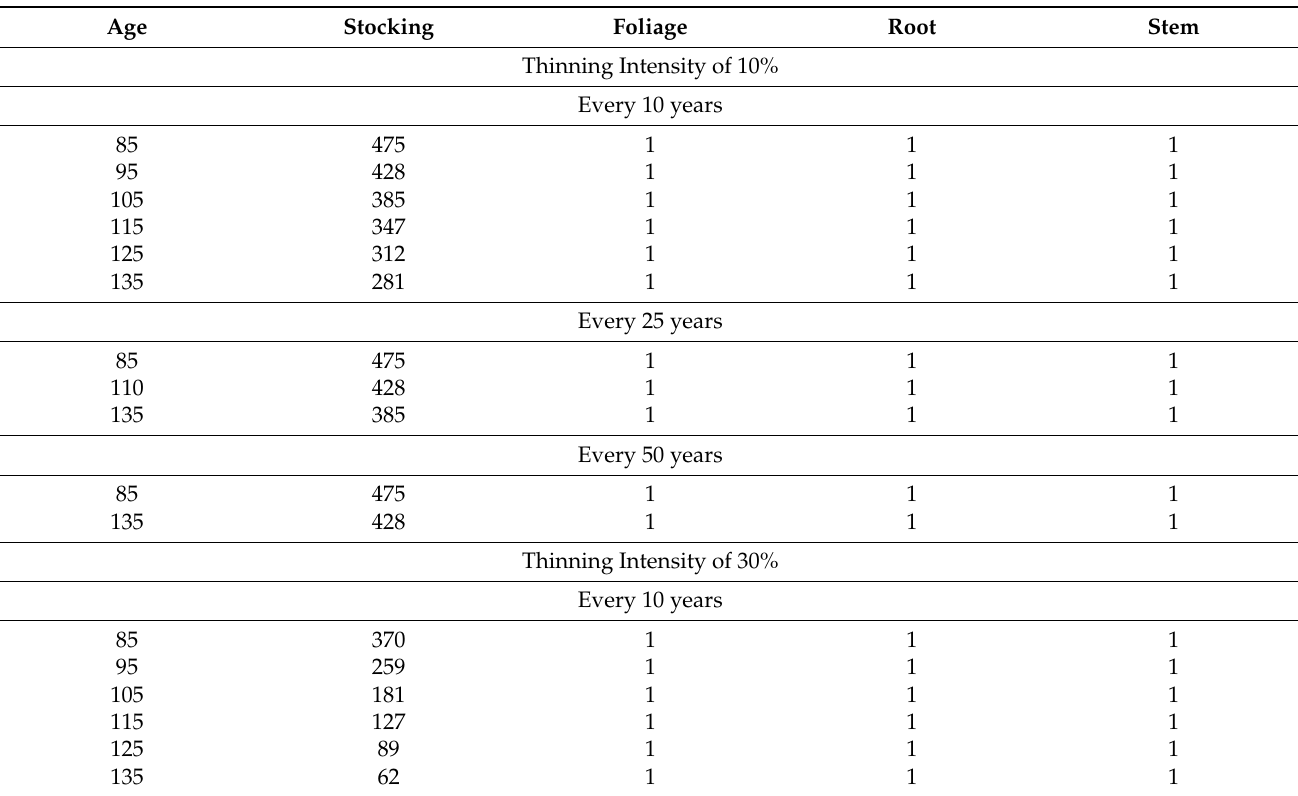
Table A2. Thinning regimes